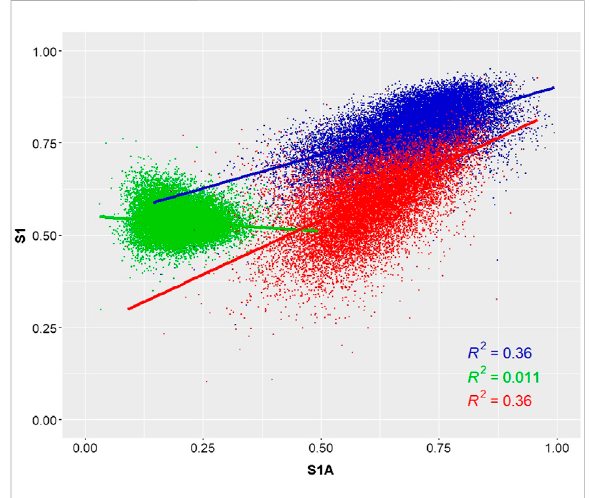
FIGURE 5 Scatter plot between Entropy (blue), Anisotropy (green) and